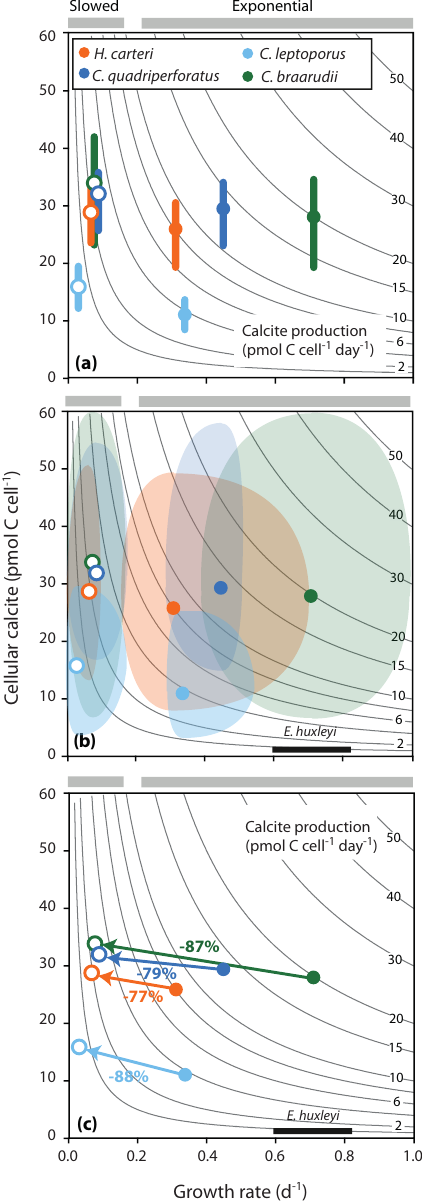
Figure 5. Calcification rates in Coccolithus , Calcidiscus and Heli- cosphaera at 22 ◦ C. (a) Mean and 25th to 75th percentile of cel- lular calcite for cultures dividing exponentially (mid-exponential- phase days, see Table S1; filled circles) and cultures no longer main- taining exponential growth (unfilled circles). (b) Range in cellular calcite, daily growth rates and calcite production observed across the experiment. (c) Percentage decrease in mean calcite produc- tion when cultures can no longer divide exponentially. The black box in b and c represents typical calcite production rates ( ∼ 0.2– 0.8pmol C cell − 1 d − 1 ) for E. huxleyi for comparison (Balch et al., 1996; Poulton et al.,